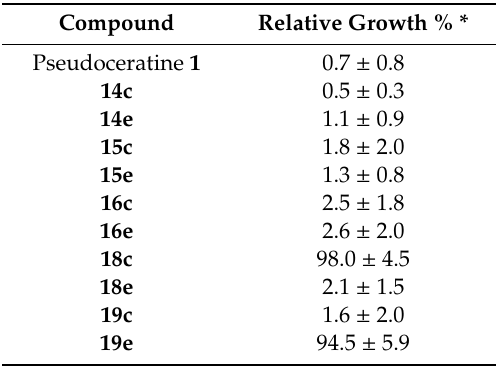
Table 3. Cytotoxic activity of 1 and other compounds in Figure 2 against HEK293 human embryonic kidney cells when treated with 16 µ M of the stated